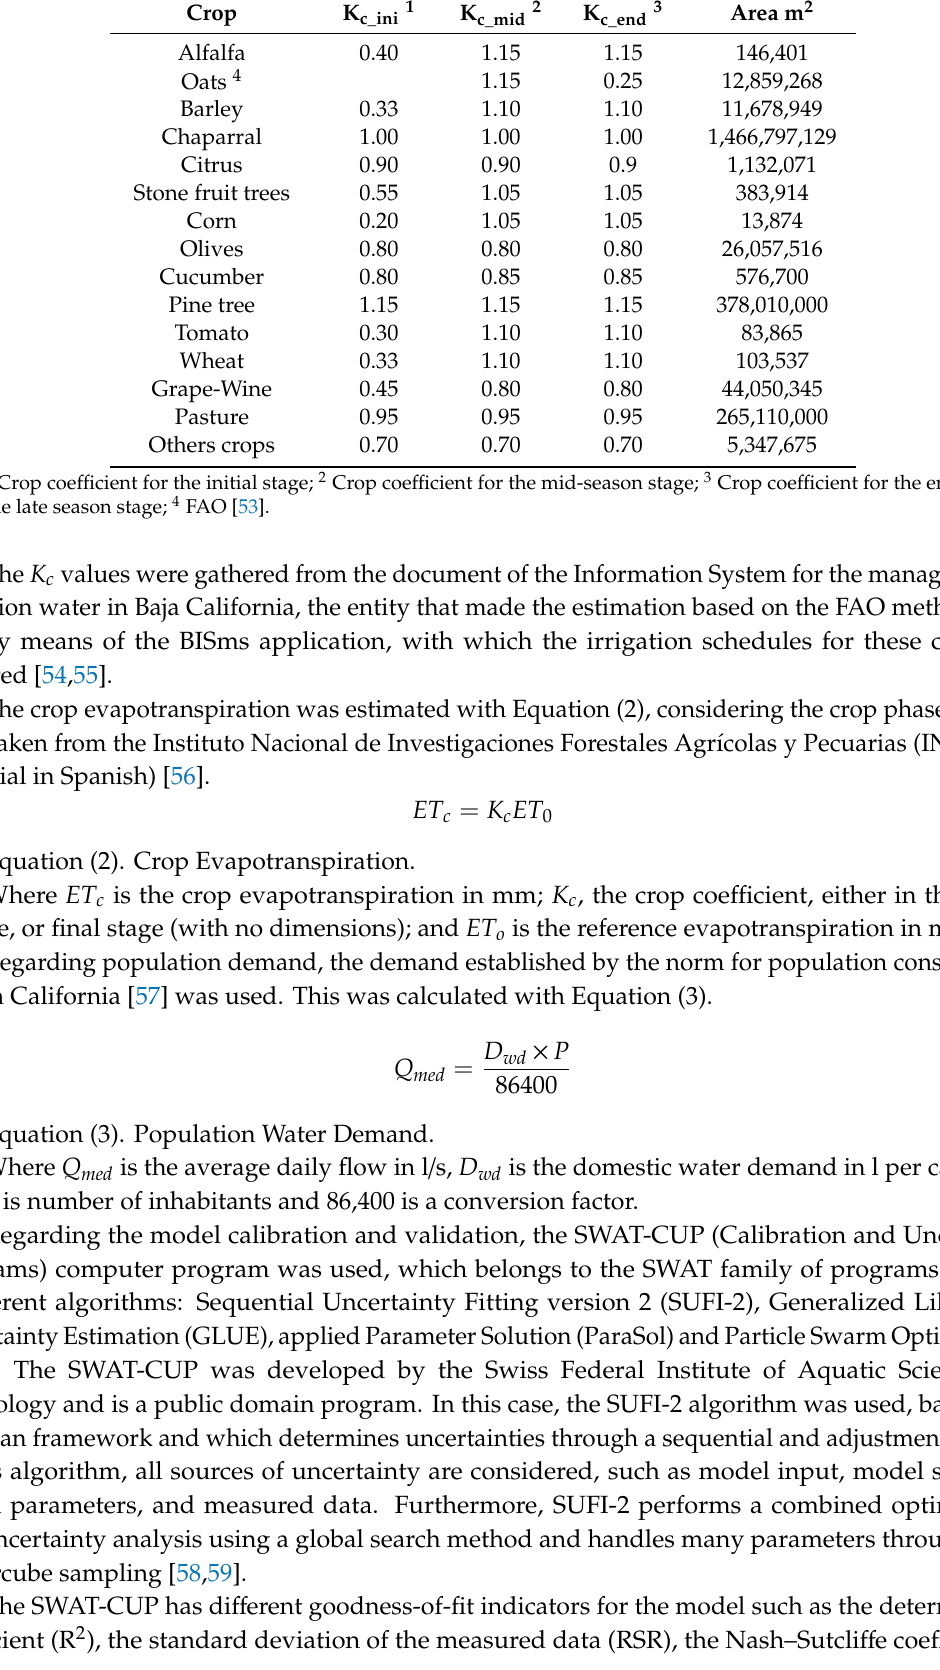
Table 1. K c_ini , K c_mid , and K c_end from the crops in the study area and their area in the basin. Crop K c_ini 1 K c_mid 2